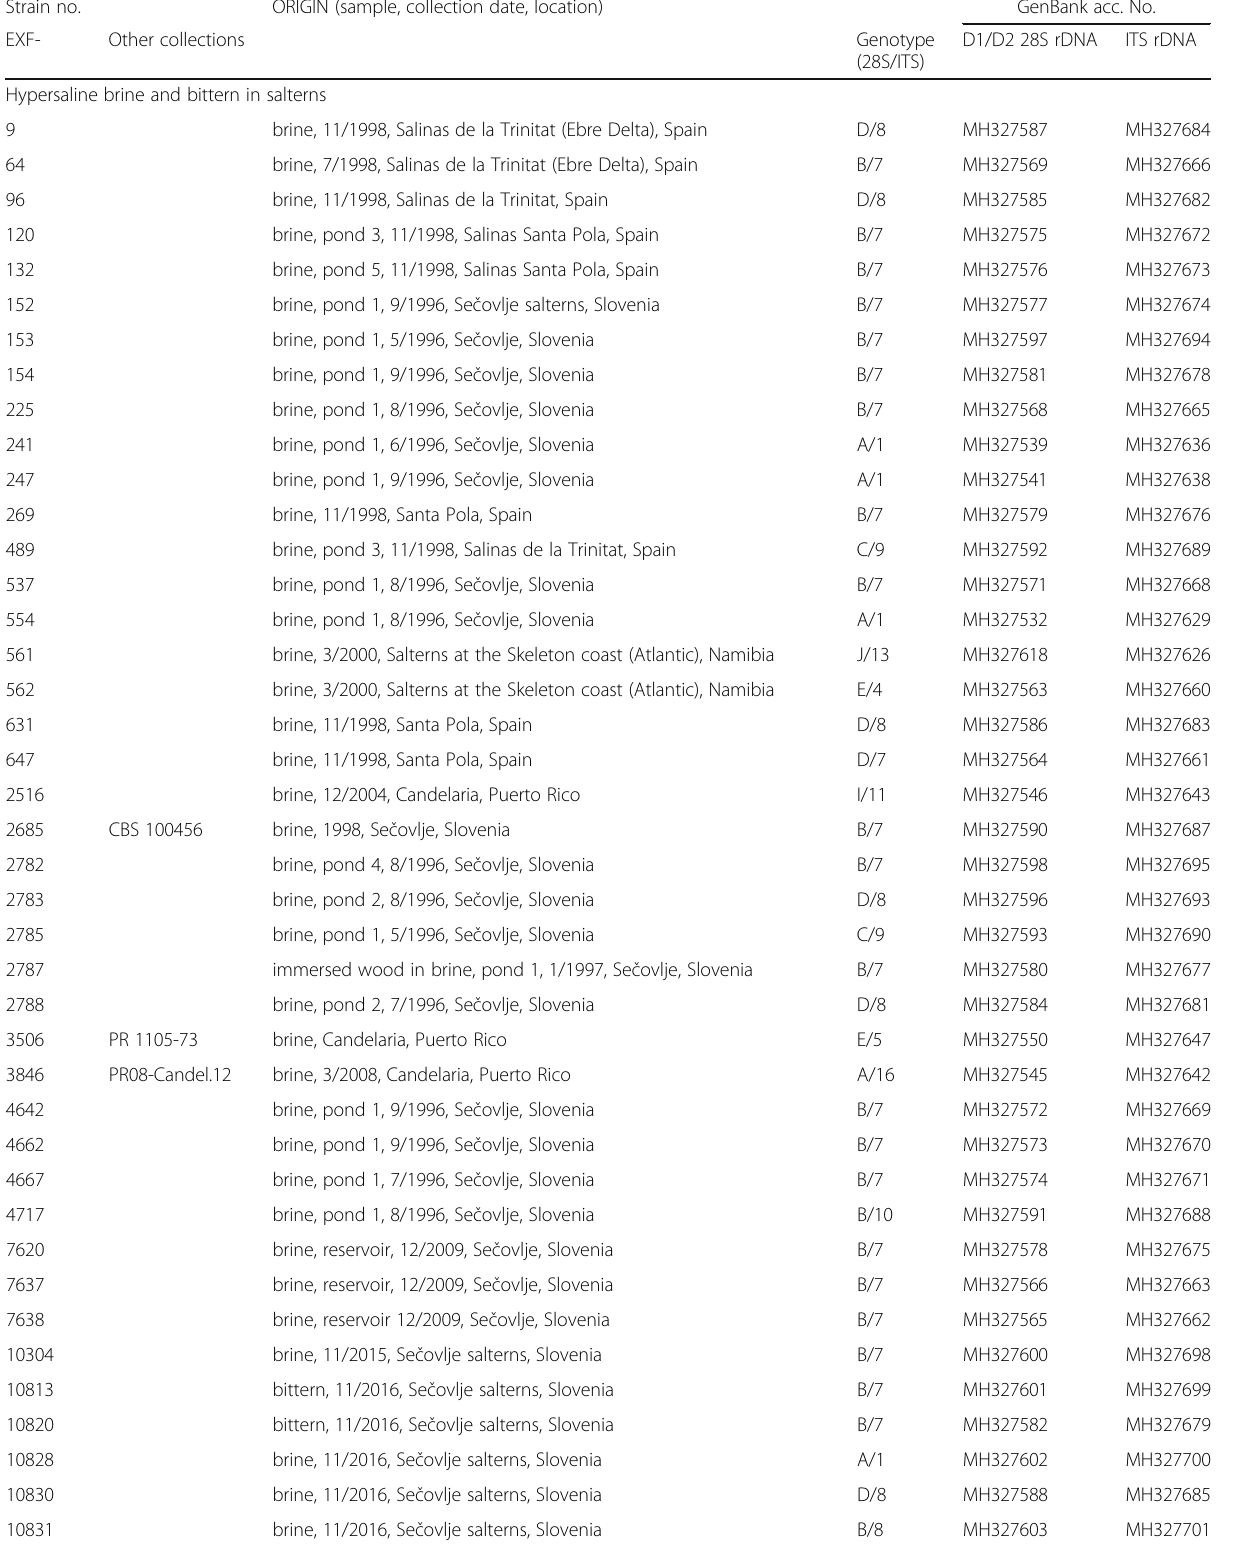
Table 1 Hortaea werneckii strains treated in this study Strain